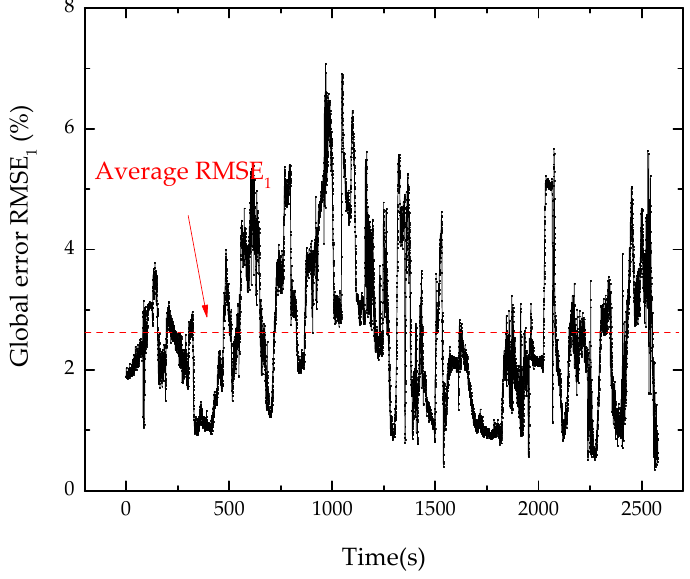
Figure 16. Global error response of